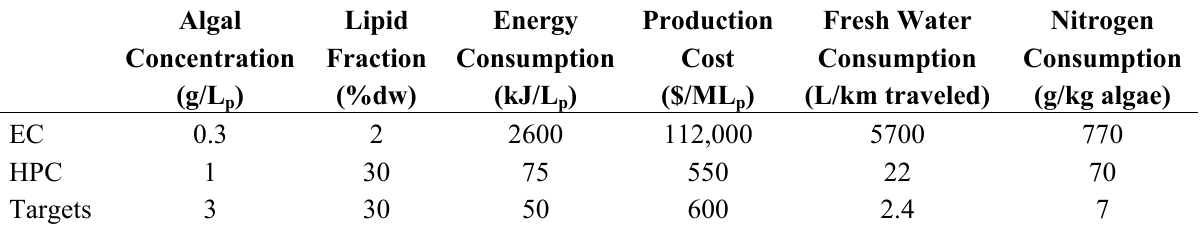
Table 6. A comparison of the Experimental Case (EC), Highly Productive Case (HPC), and the targets needed for sustainable large-scale algal biofuel